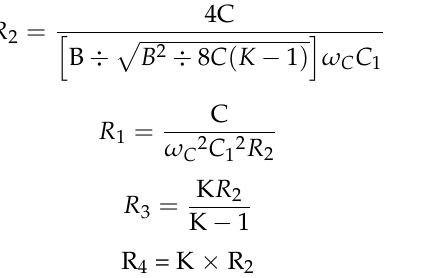
Figure 4. Second order active high-pass filter circuit of voltage controlled voltage source.